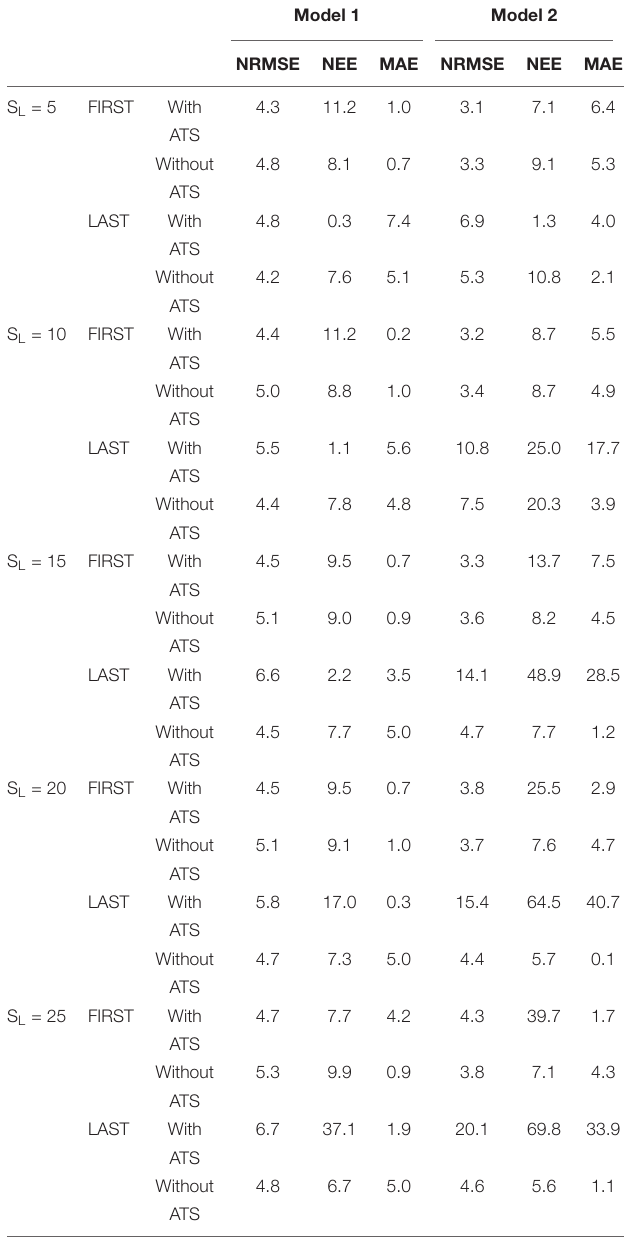
TABLE 5 | Error estimation (%) for all conducted online RTHS tests with different ML models with respect to the pure analytical